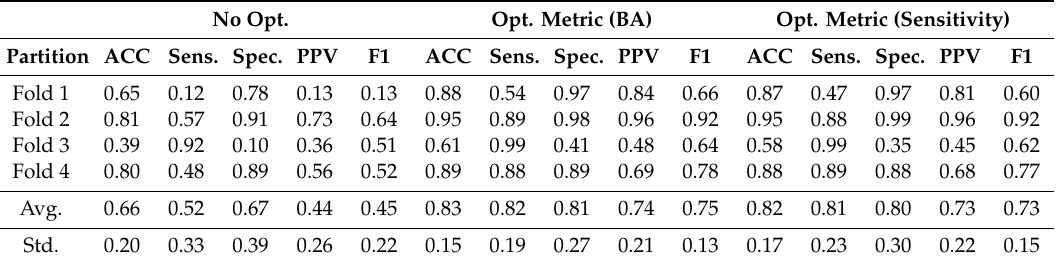
Table 1. Superpixel classification results of the validation set in each fold using the SVM with Linear Kernel, with and without hyperparameter optimization. No Opt. Opt. Metric (BA) Opt. Metric (Sensitivity) Partition ACC Sens. Spec.